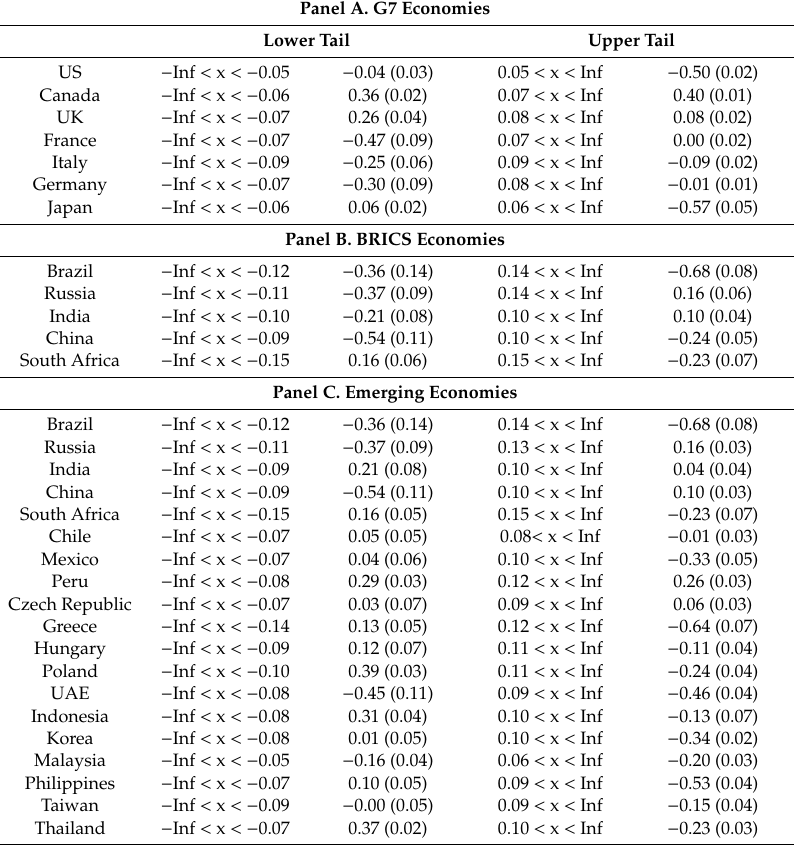
Table 1. Piecewise distribution (lower and upper tails) of G7, BRICS and emerging markets over the period